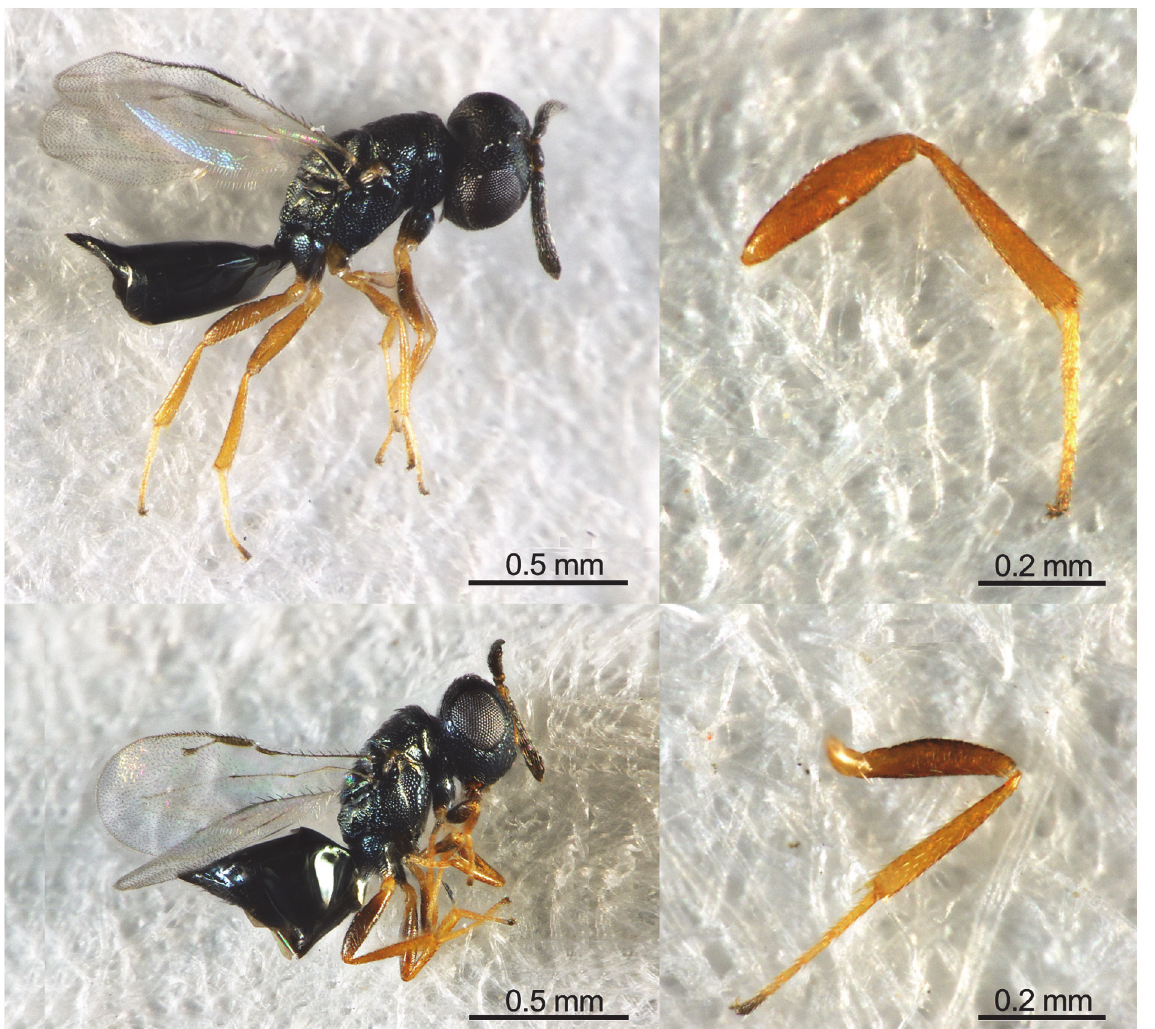
Fig 2. Two types of P . vindemmiae females and hind tibia. Upper and lower parasitoids are normal females and those from hyperparasitism, respectively. Offspring from hyperparasitism were smaller. Photograph by W Chen.